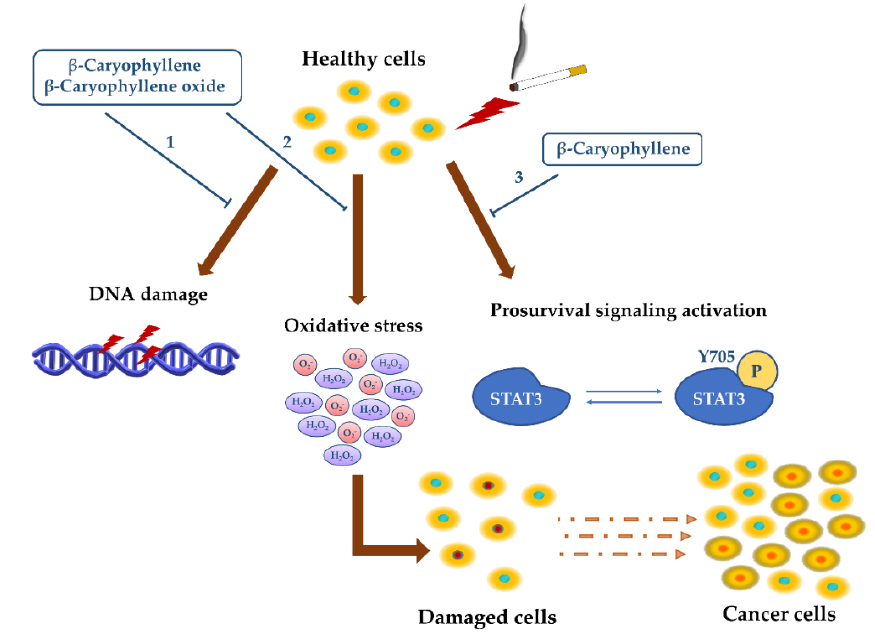
Figure 5. Genoprotective effects of β-caryophyllene and β-caryophyllene oxide against the